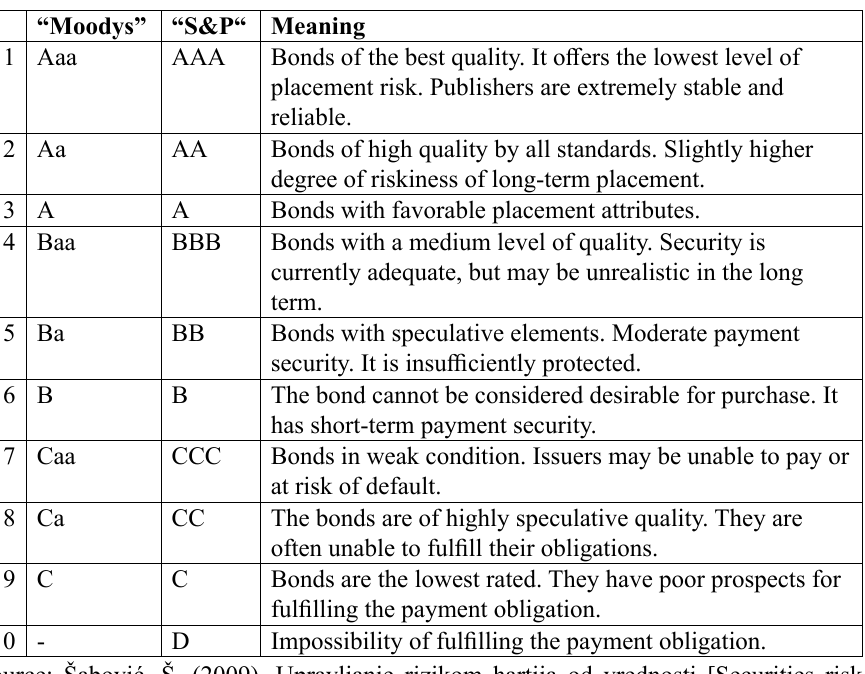
Table 2. Bond system